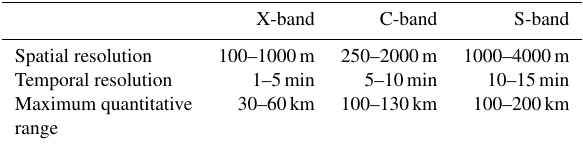
Table 2. Typical operating resolutions and maximum ranges for dif- ferent types of weather radars used in hydrological